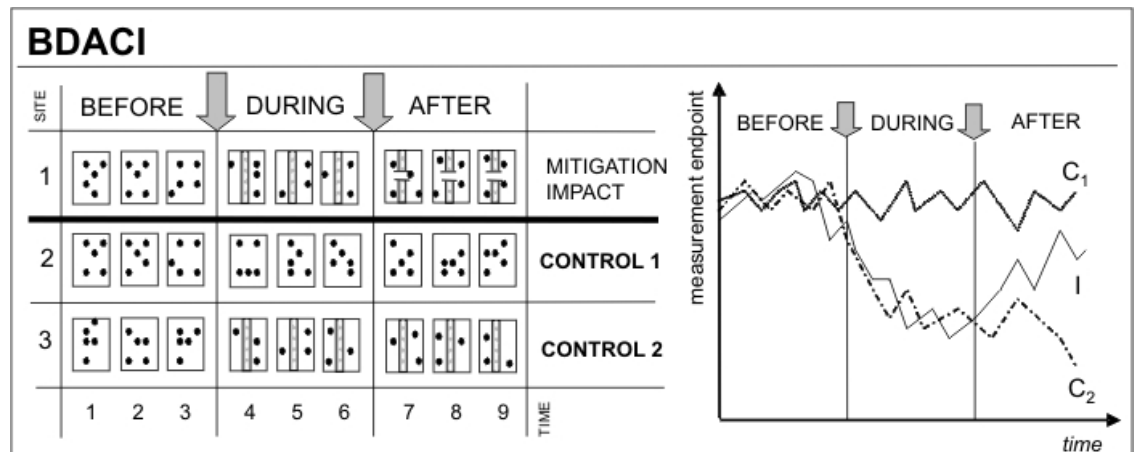
Fig. 5 . Study designs and hypothetical results for Question 3: Under what circumstances can road effects be mitigated? The study types include before-after-control-impact (BACI), before-after (BA), and control-impact (CI)